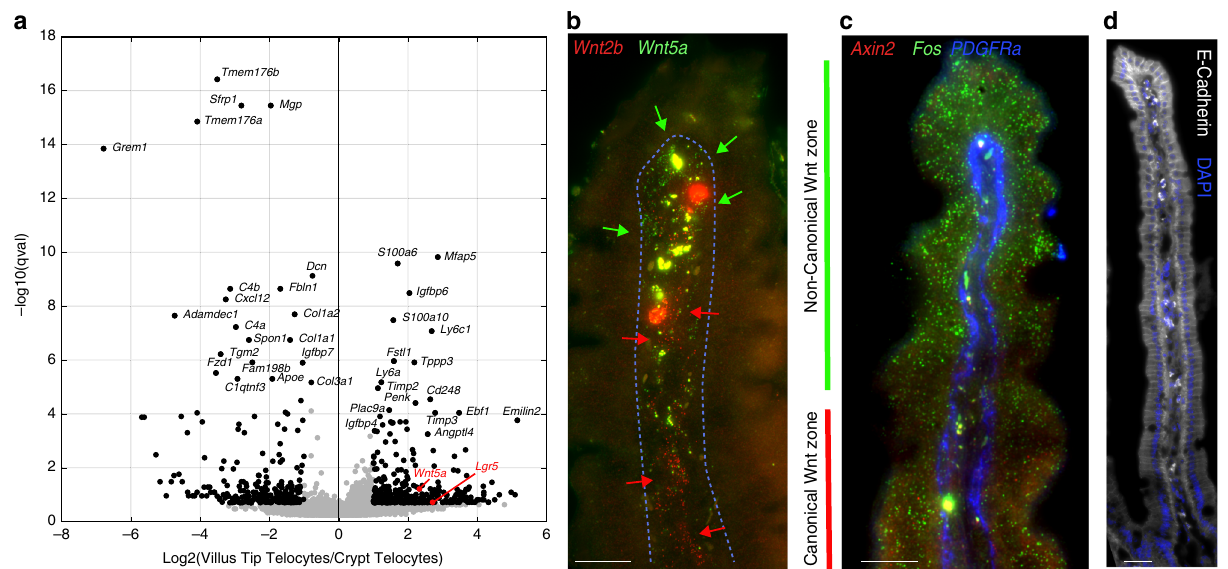
Fig. 5 VTTs implement a spatial switch from canonical to non-canonical Wnt signaling. a Volcano plot demonstrating differential gene expression between VTTs and crypt telocytes. Black dots have q -values < 0.2 and expression fold change larger than 2 or smaller than ½. Wnt5a and Lgr5 are marked in red. b Spatial shift in the stroma from the expression of canonical Wnt2b (red dots, marked by red arrows) to non-canonical Wnt5a (green dots, marked by green arrows). Scale bar – 20 µ m. c Axin2 (red dots) is expressed broadly along the villus axis and repressed at the villus tip. Fos (green dots) is highly expressed in villus tip enterocytes. scale bar – 20 µ m. d E-Cadherin protein (gray), encoded by Cdh1 gene, is induced in villus tip enterocytes. Large blobs in b – d are auto fl uorescent signals originating in immune cells. scale bar – 30 µ